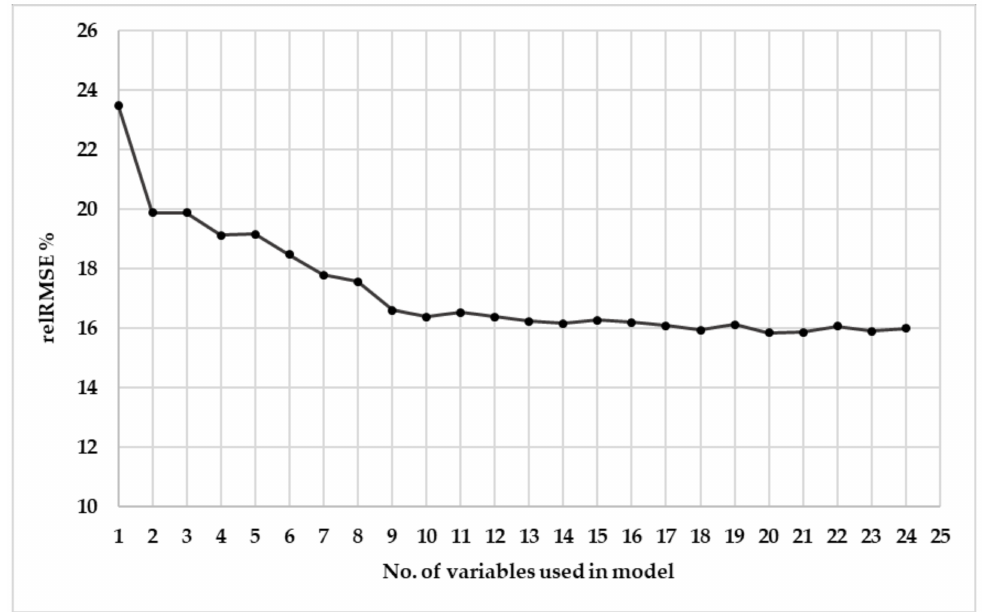
Figure 4. Relative RMSEs obtained by backward elimination of variables from the RF